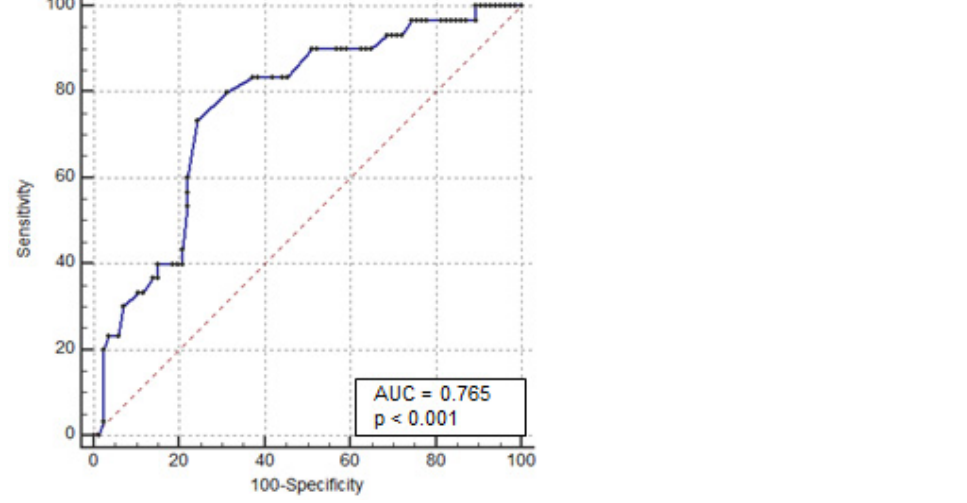
Figure 3. Receiver operating characteristic curves for colectomy based on colonic dilation (X-ray of the abdomen) at admission. 3.3. Colectomy-Free Survival during Follow-Up A colectomy-free survival curve was developed based on the absence or presence of one or two of the previously identified predictors. A total of 56 patients (48%) had no risk factor, 44 patients (38%) had one risk factor, and 16 patients (14%) had two risk factors.